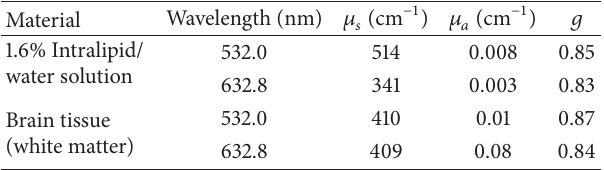
0.0 Figure 8: Dependence of optical probing depth on the dis- tance between the fibres. Green: excitation wavelength 𝜆 = 532 nm (circles—diffusely scattered radiation, full line—solution of (2), triangles—fluorescent radiation, and dashed line—approxi- mation with logarithmic function). Red: excitation wavelength 𝜆 = 632.8 nm (circles—diffusely scattered radiation, full line— solution of (2), triangles—fluorescent radiation, and dashed line— approximation with logarithmic function). Table 2: Optical properties of the brain tissue model [15,